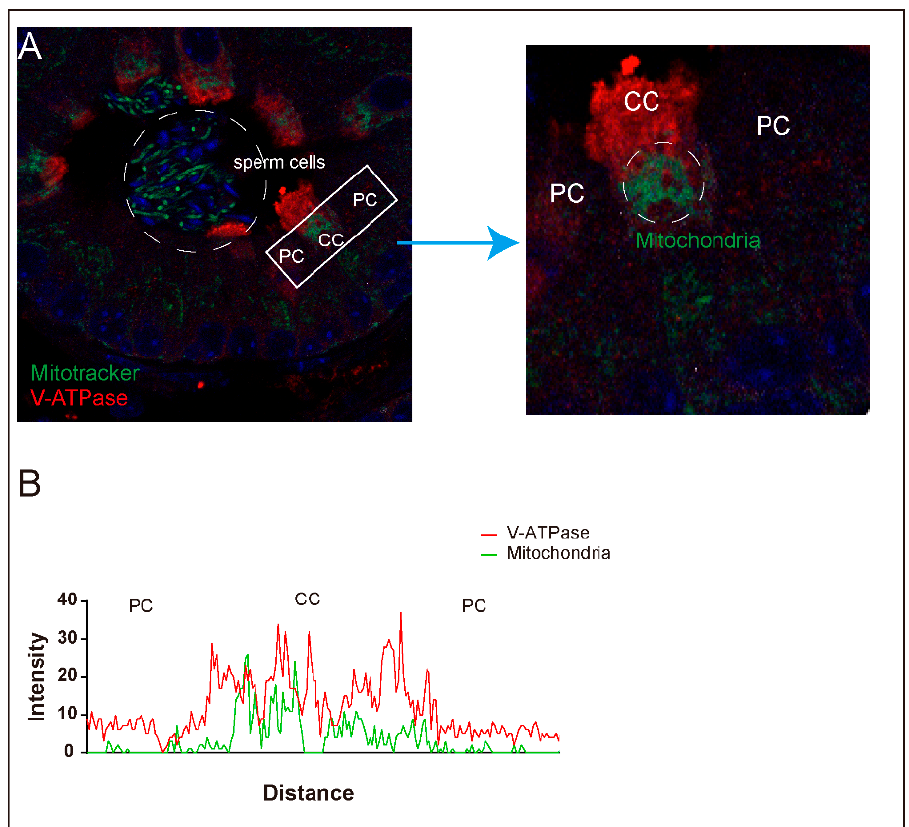
Figure 3. Different distribution of mitochondria between clear cells and other cells in the epididymis. Mitochondria were labelled with a Mitotracker (Green) and clear cells (CCs) were labelled with V-ATPase (Red). Representative images ( A ) show the different distribution of mitochondria between clear cells and other cells, such as principal cells (PCs, unlabeled cells). The fluorescence intensity results ( B ) indicated that mitochondria are more enriched in clear cells than principal cells. The images were obtained using Nikon Eclipse Ni-U equipped with a Nikon DS-Ri2 camera and the Nikon NIS-Elements Fr software (Version 5.11, Nikon Instruments Inc., Melville, NY, USA).